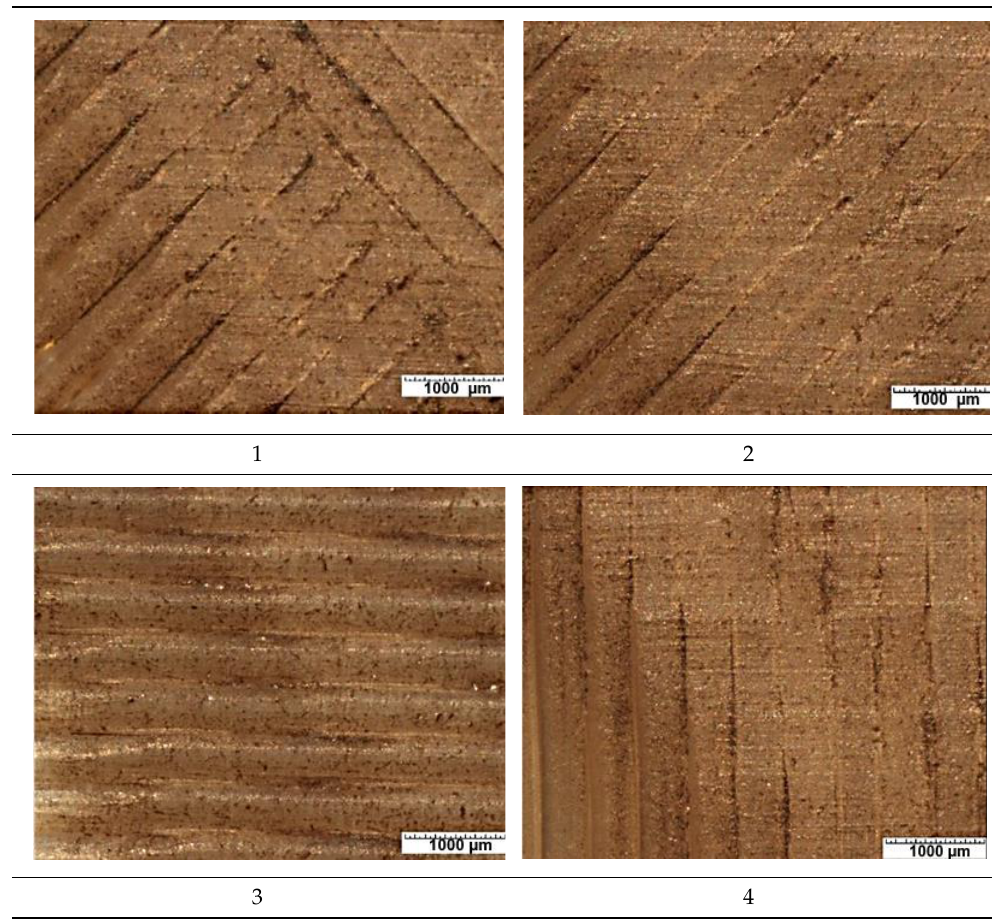
Table 10. Microscopic images of the sample surfaces of Samples 1 – 10.